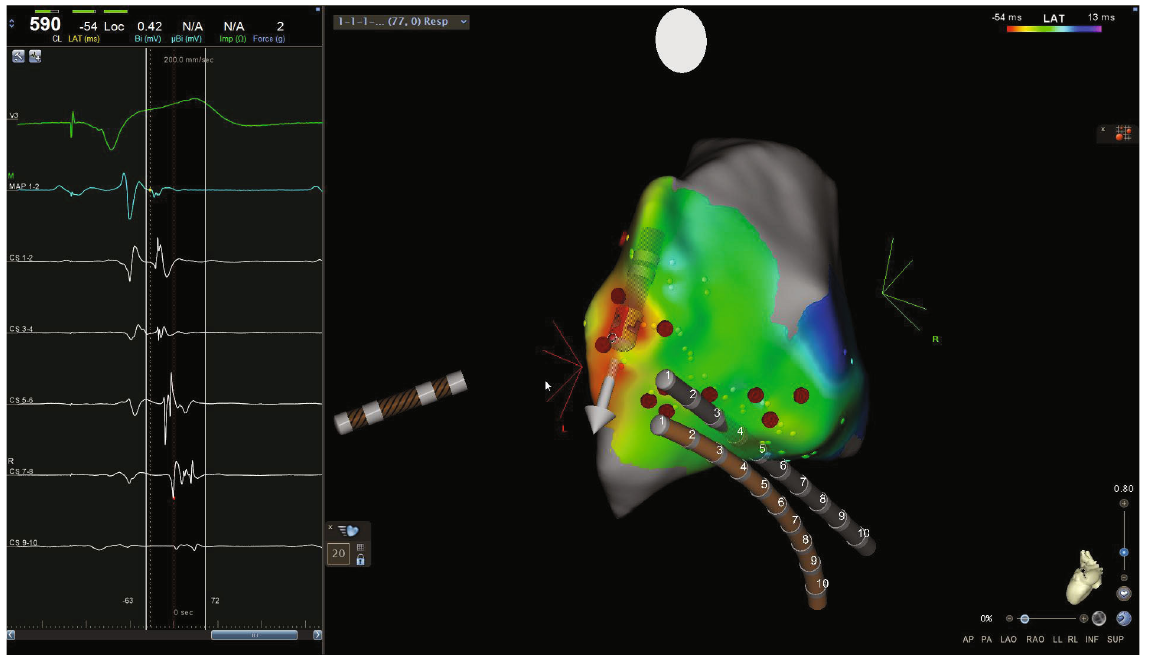
Figure 4: 3D mapping and intracavitary recordings con fi rming the presence of a left anterolateral